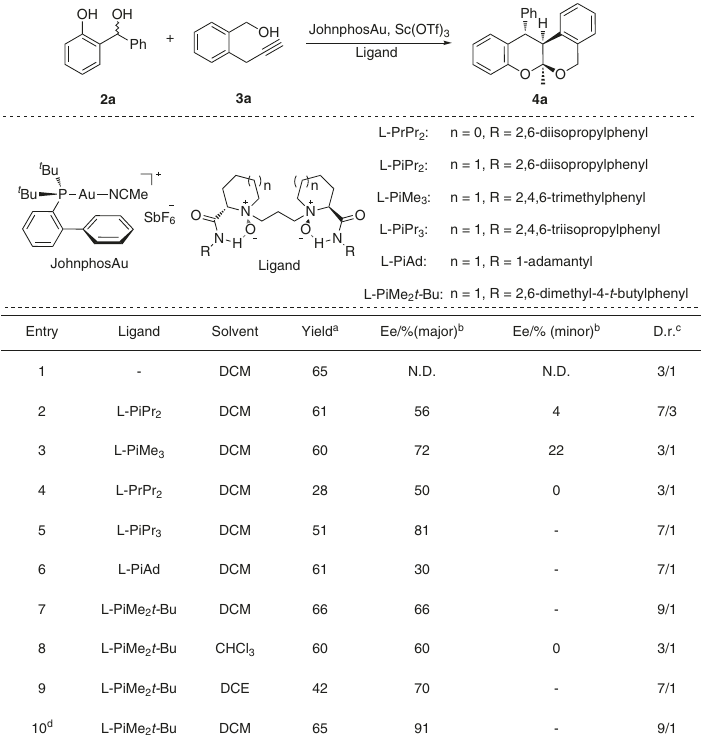
Fig. 2 Optimization of the reaction. All reactions were carried out on a 0.1 mmol scale with 1 eq precursor of o -QMs 2a , 1.2 eq 3a , 10 mol% of Sc(OTf) 3 , 11 mol% of ligand and 5 mol% of JohnphosAu in DCM (1 mL) at room temperature. a Isolated yield. b Determined by chiral HPLC. c Determined by by crude 1 H-NMR. d Reaction temperature: 6